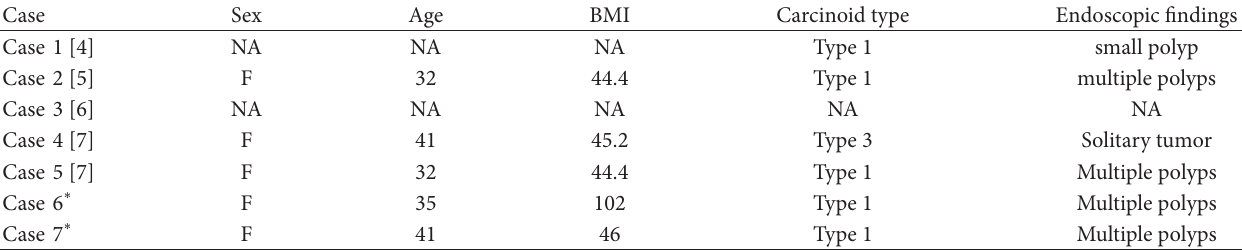
T 1: Summary of previously reported cases of gastric carcinoid diagnosed by pre-briatric surgery